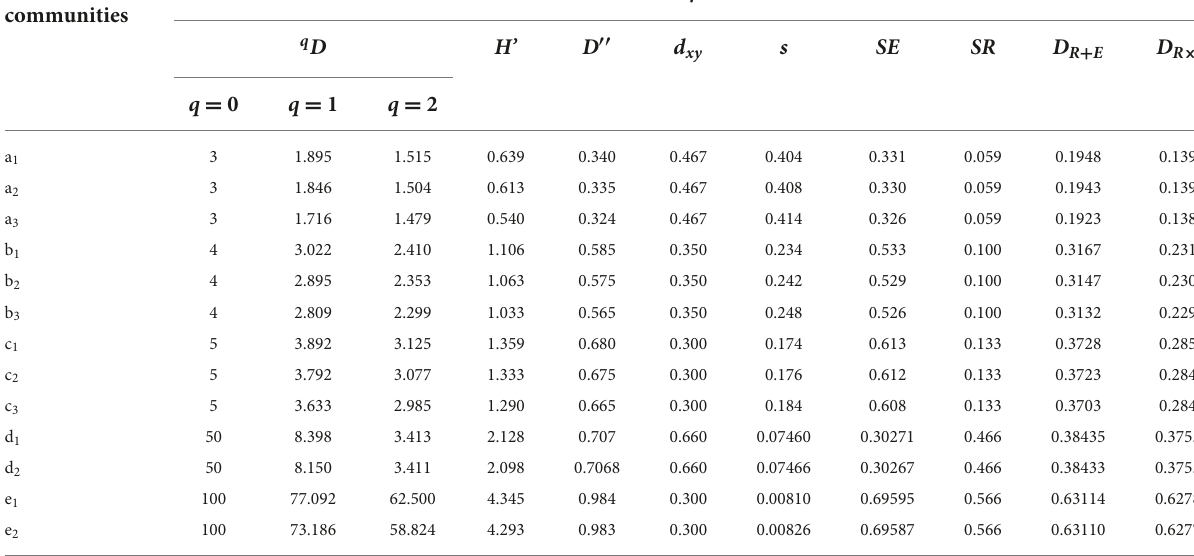
TABLE 3 Compared the value of different diversity indices using the simulated datasets in Table 1 . Simulated communities